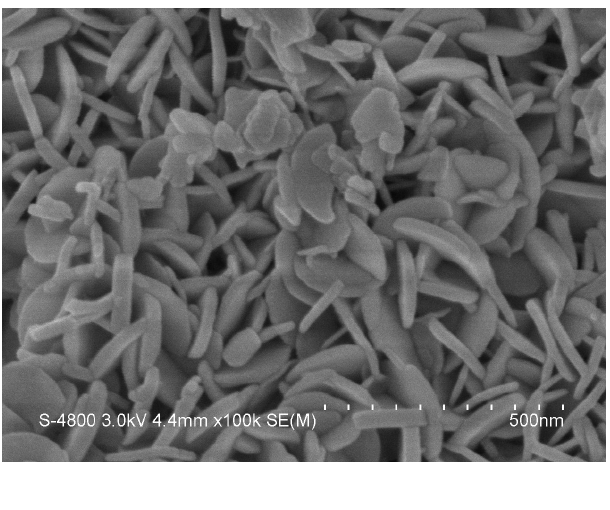
Figure 3. SEM image of the commercial NaBiO